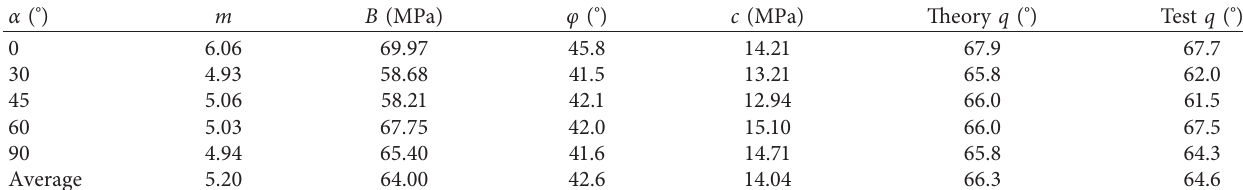
Table 8: Parameters of Coulomb–Navier criterion of tight sandstone with different dip